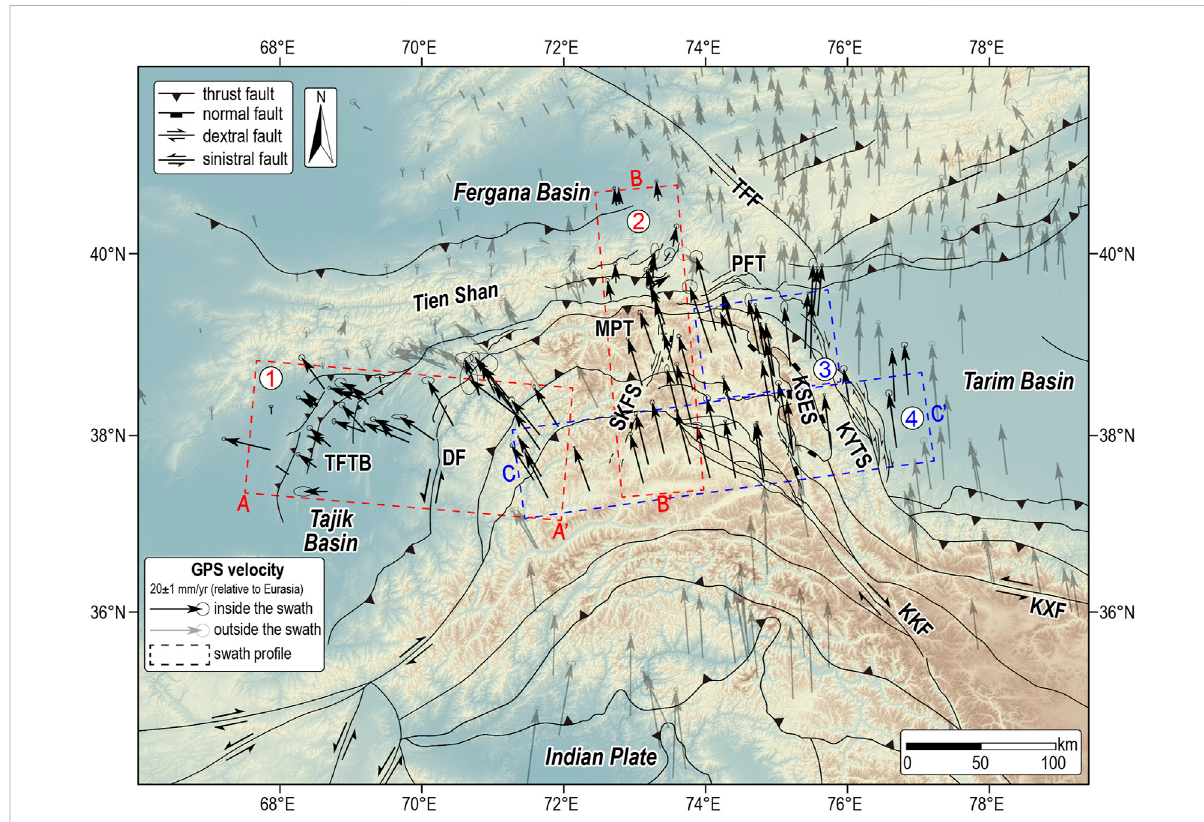
FIGURE 3 The GPS velocity fi eld of the Pamir salient and its adjacent regions, relative to the Eurasian plate. Black arrows bounded by red and blue dashed swaths denote GPS velocity vectors used in this study to analyze decadal-scale deformation rates. Fault names same as Figure